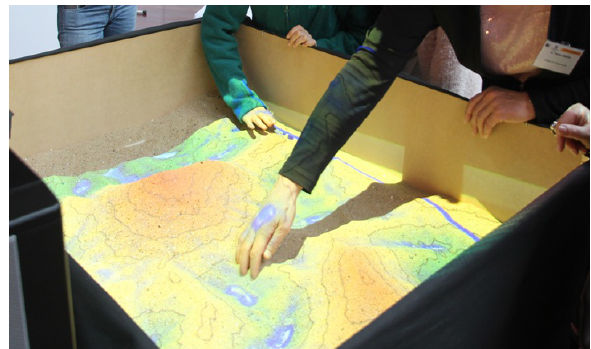
Figure 4. Water flow simulation by Simulation Augmented Reality Sandbox (Courtesy of B. D. Vliegher Dr. C. Stal, Ph. de Mayer, Gent University,